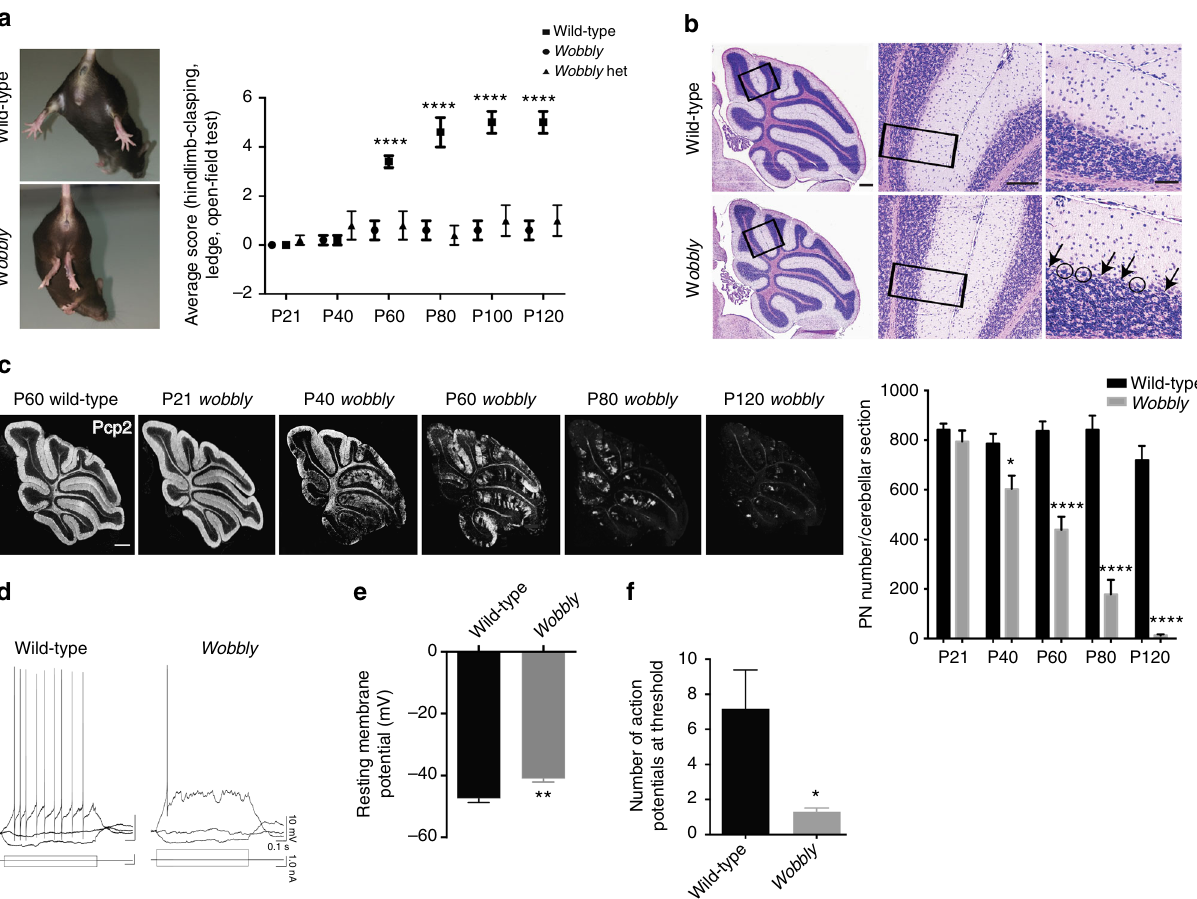
Fig. 1 Ataxia and neurodegeneration in wobbly mice. a Left: hindlimb clasping in wild-type and mutant animals. Right: behavioral analysis of the wobbly phenotype relative to wild-type ( n = 10 (5 males and 5 females) for each of the genotypes; homozygous wobbly animals are presented as wobbly and heterozygous as wobbly het). b H&E staining of P60 cerebellar sagittal. Arrows indicate PN loss, and circles mark degenerating PNs. Black rectangles represent magni fi ed areas. c Pcp2 immuno fl uorescence and PN quanti fi cation in wobbly and wild-type cerebella. d Representative raw traces of train of action potentials in PNs elicited by current injections of 50 and 100 pA in wild-type and wobbly cells, respectively. e Resting membrane potential of wobbly ( − 40.9± 1.2mV, n = 10) and wild-type ( − 47.3 ± 1.4 mV, n = 18) PNs at P21 – 24. f Number of action potentials of wobbly ( n = 10) and control ( n = 13) PNs at threshold elicited by current injections. For ( b ) and ( c ) n = 5 for each of the genotypes and ages presented; representative images are shown. Scale bars: ( b ) left panel, ( c ) 500 μ m; ( b ) middle panel, 100 μ m; ( b ) right panel, 50 μ m. Statistical evaluation: ( a , c ) two-way ANOVA and Sidak ’ s multiple comparisons test; ( e , f ) two-tailed t test. Statistically signi fi cant differences are indicated ( * P ≤ 0.05; ** P ≤ 0.01; **** P ≤ 0.0001). Data represent mean